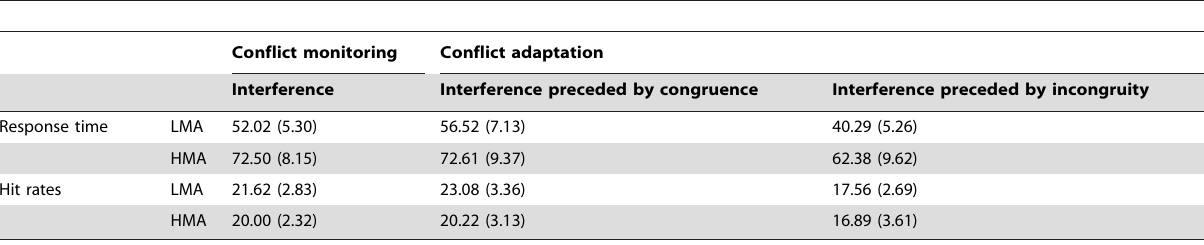
Table 2. Response times (mean of medians) and accuracy (percentage of hits) (SEM in brackets) for the LMA and HMA groups for conflict monitoring and for conflict adaptation